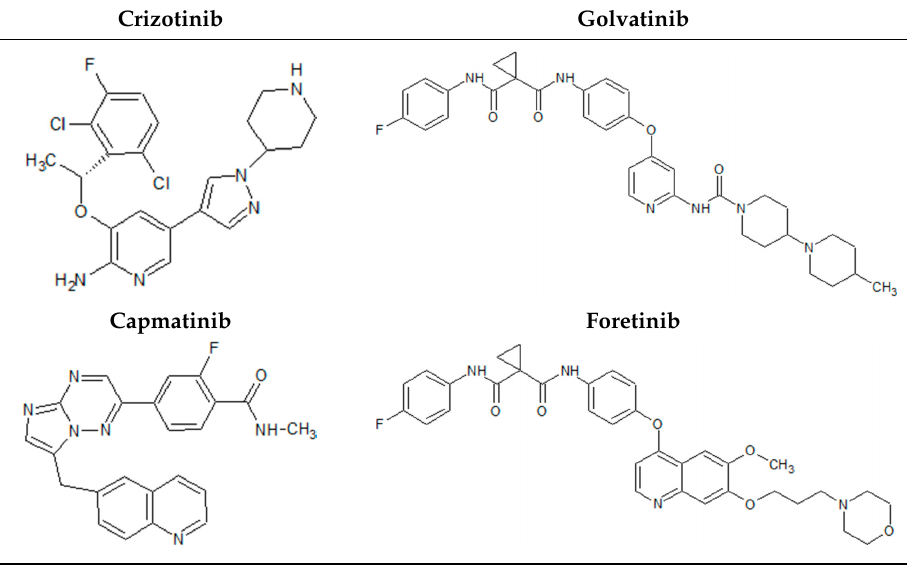
Table 2. Structures of small molecule inhibitors of c-Met.